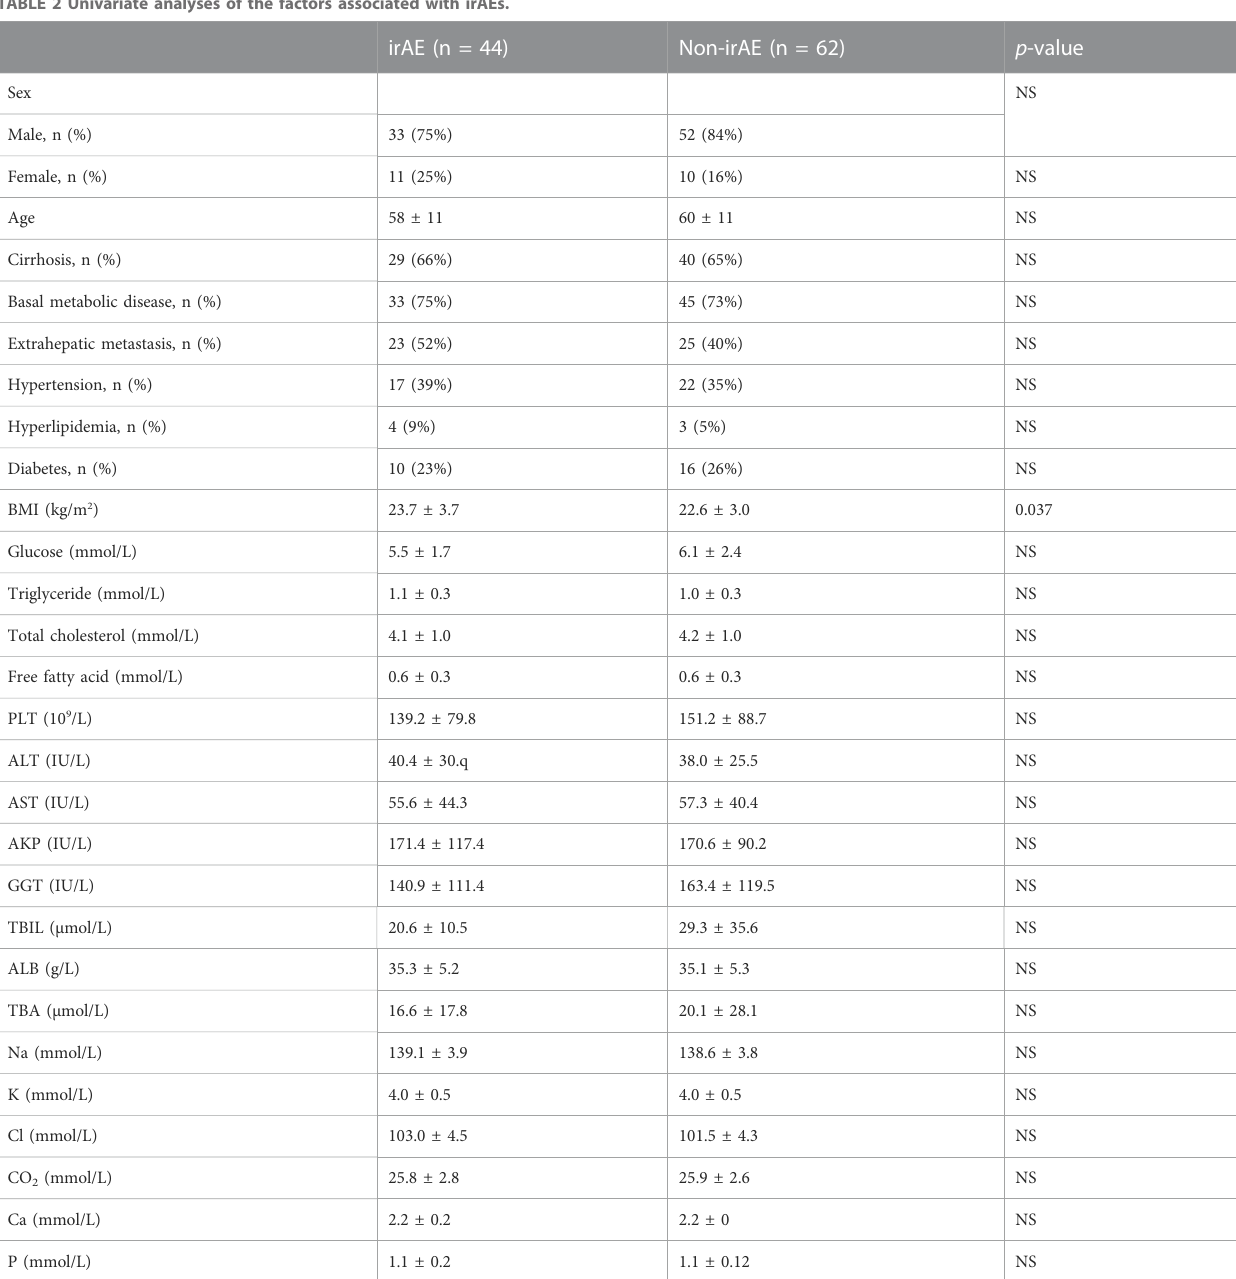
TABLE 2 Univariate analyses of the factors associated with